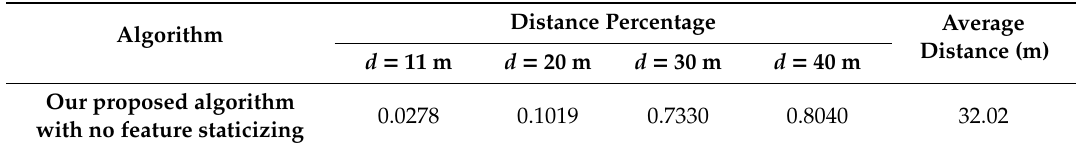
Table 7. The distance percentage and average distance of our proposed algorithm with no feature staticizing for the testing